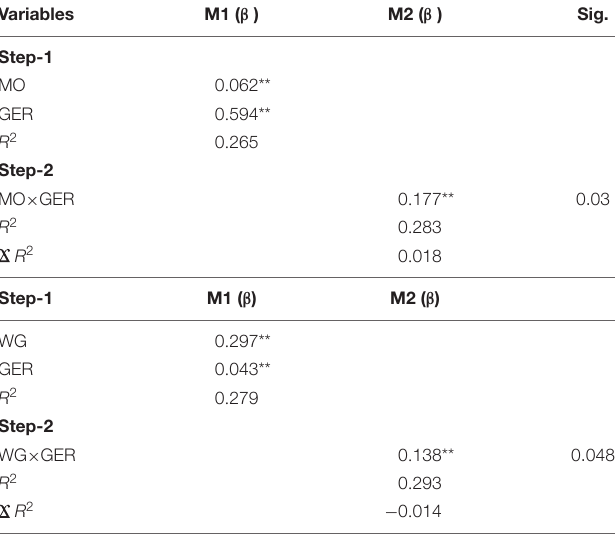
TABLE 6 | Hierarchal regression for